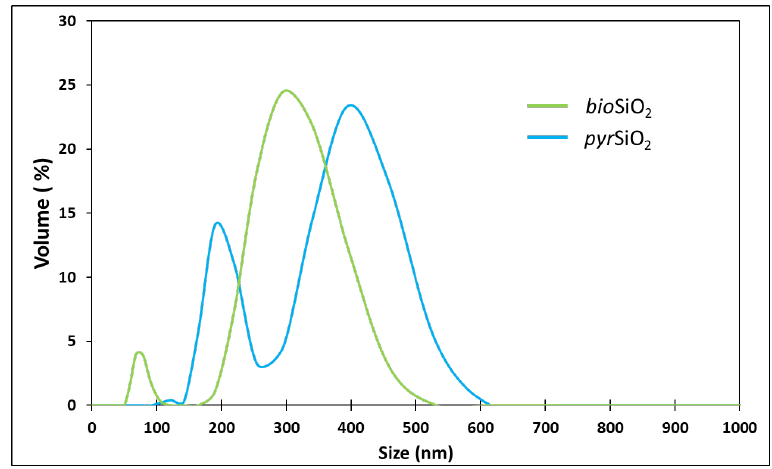
Figure 3. Particle diameters size distributions of bio SiO 2 (green line) and pyr SiO 2 (blue line) powders.